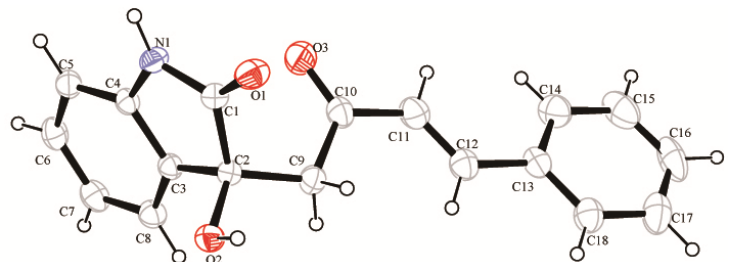
Figure 2. X-ray crystal structure of 3a